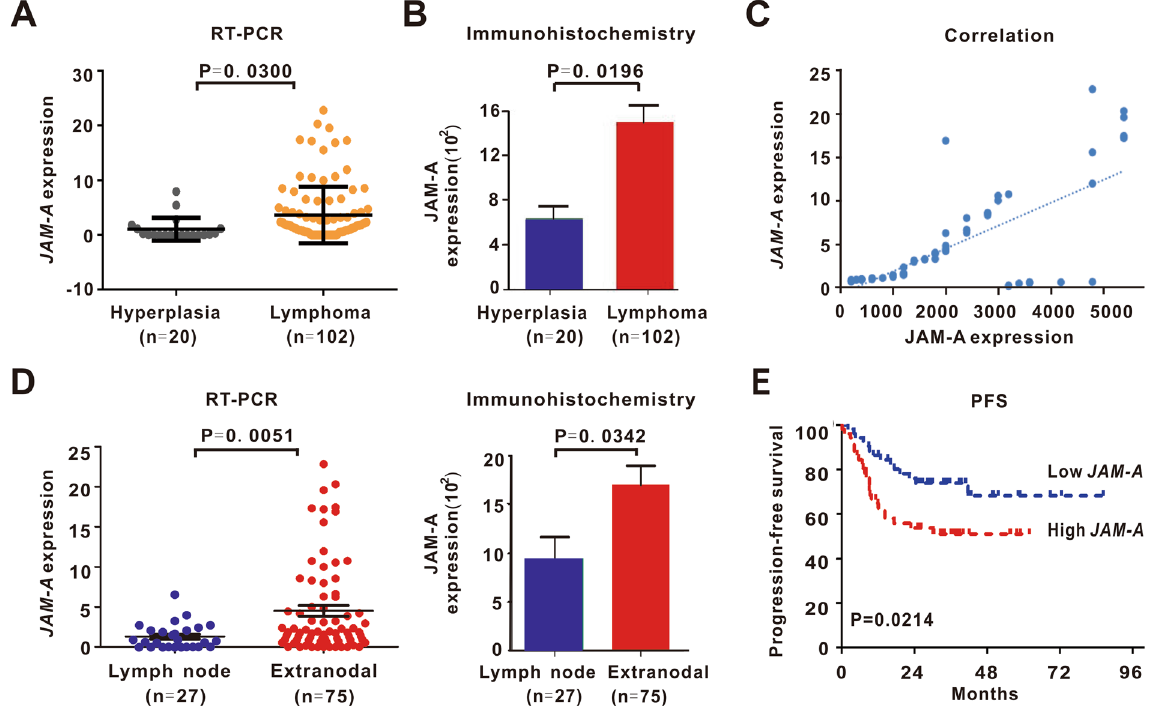
Figure 1. JAM-A overexpression was related to extranodal involvement and poor disease outcome in DLBCL. ( A , B ) JAM-A gene ( A ) and JAM-A protein ( B ) were overexpressed in DLBCL. ( C ) JAM-A gene expression correlated well with JAM-A protein expression. ( D ) DLBCL patients with extranodal involvement had higher JAM-A gene and JAM-A protein expression than those only with nodal lesions. ( E ) Patients in high JAM-A expression group had poor progression-free survival